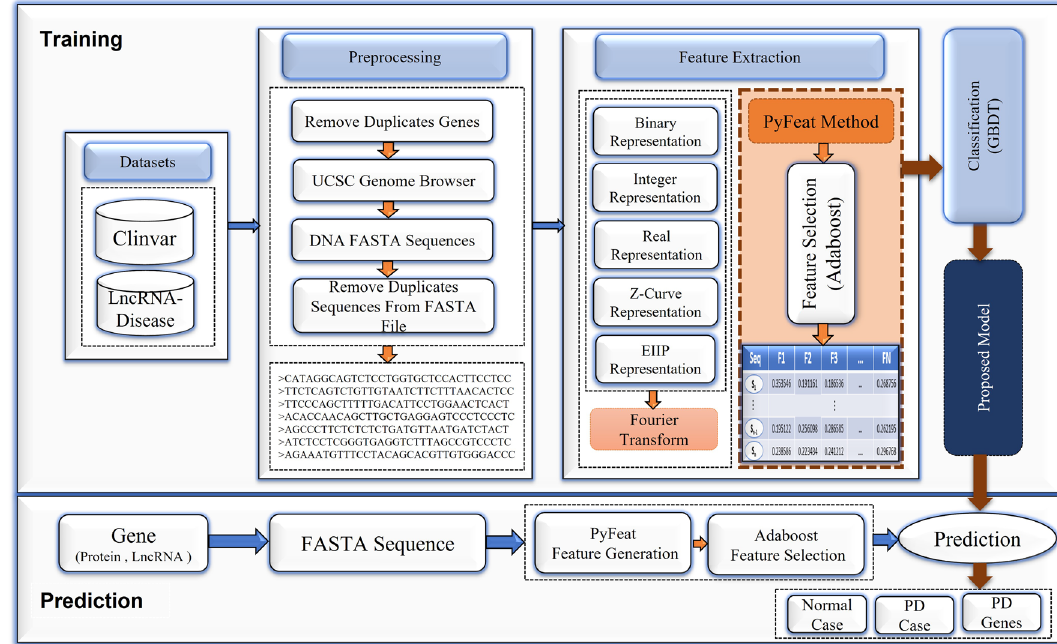
Figure 1. The proposed prediction system for identifying protein and lncRNA genes associated with